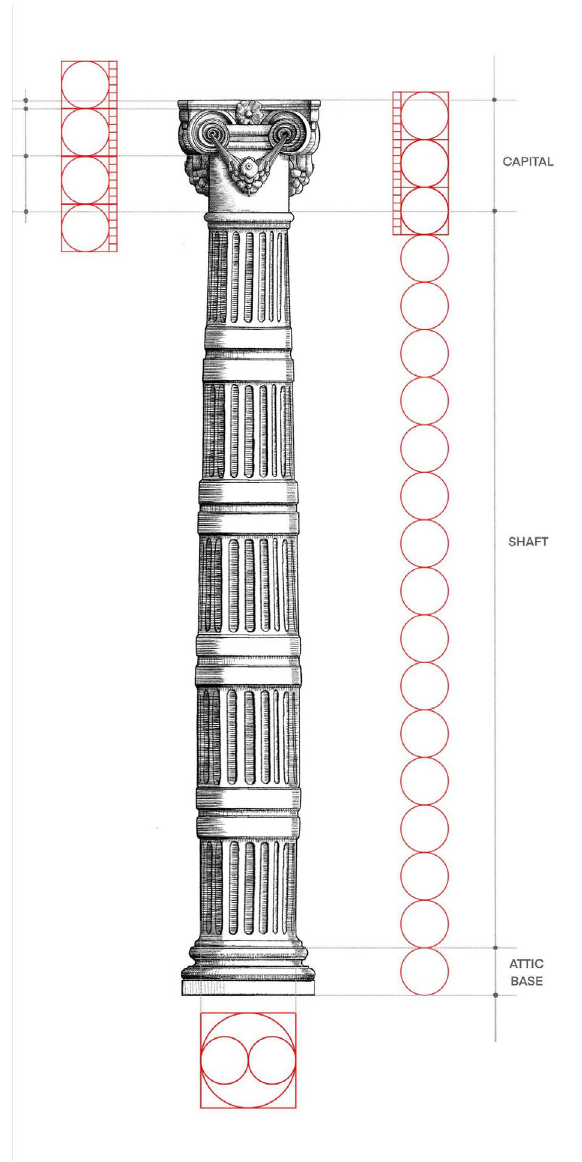
Figure 4 . Dimensional analysis of the